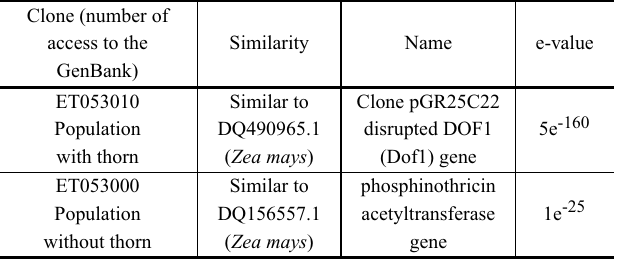
Analysis of Bioinformatics (BLASTn) of the selected clones, by RAPD, in Caryocar brasiliense (Camb.) with and without thorn at the endocarp.